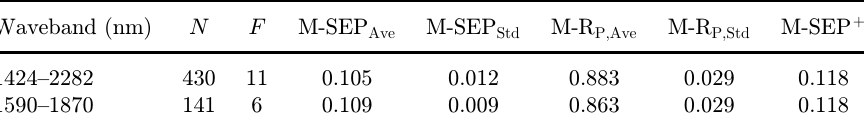
Table 2. Modeling prediction accuracy and stability that correspond to the optimal MWPLS waveband and to the equivalent optimal waveband.